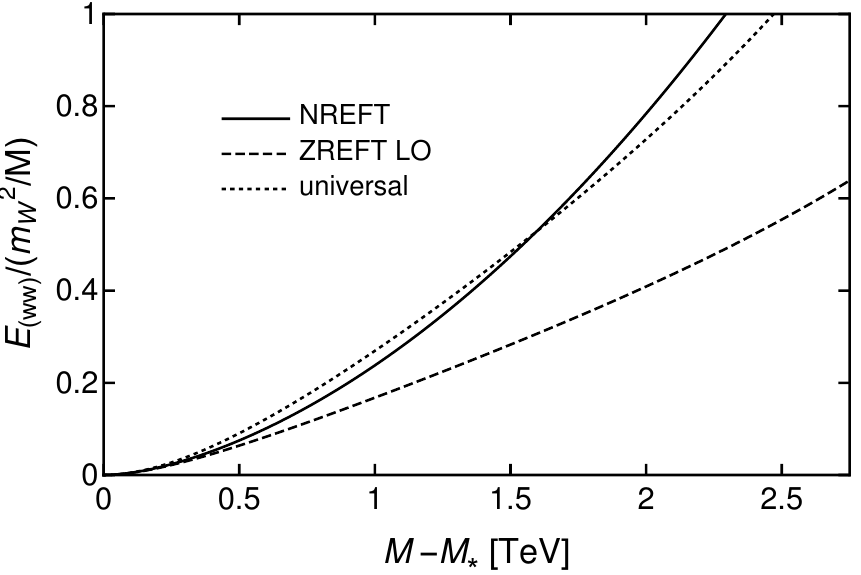
Figure 14 . The binding energy of the wino-pair bound state as a function of the wino mass M . The binding energy for (cid:11) = 0 is shown for NREFT (solid line) and for ZREFT at LO (dashed line). The universal approximation in eq. (3.17), with the Pad(cid:19)e approximant for a 0 ( M ) analogous to eq. (3.13) but for (cid:11) = 0, is shown as a dotted curve.